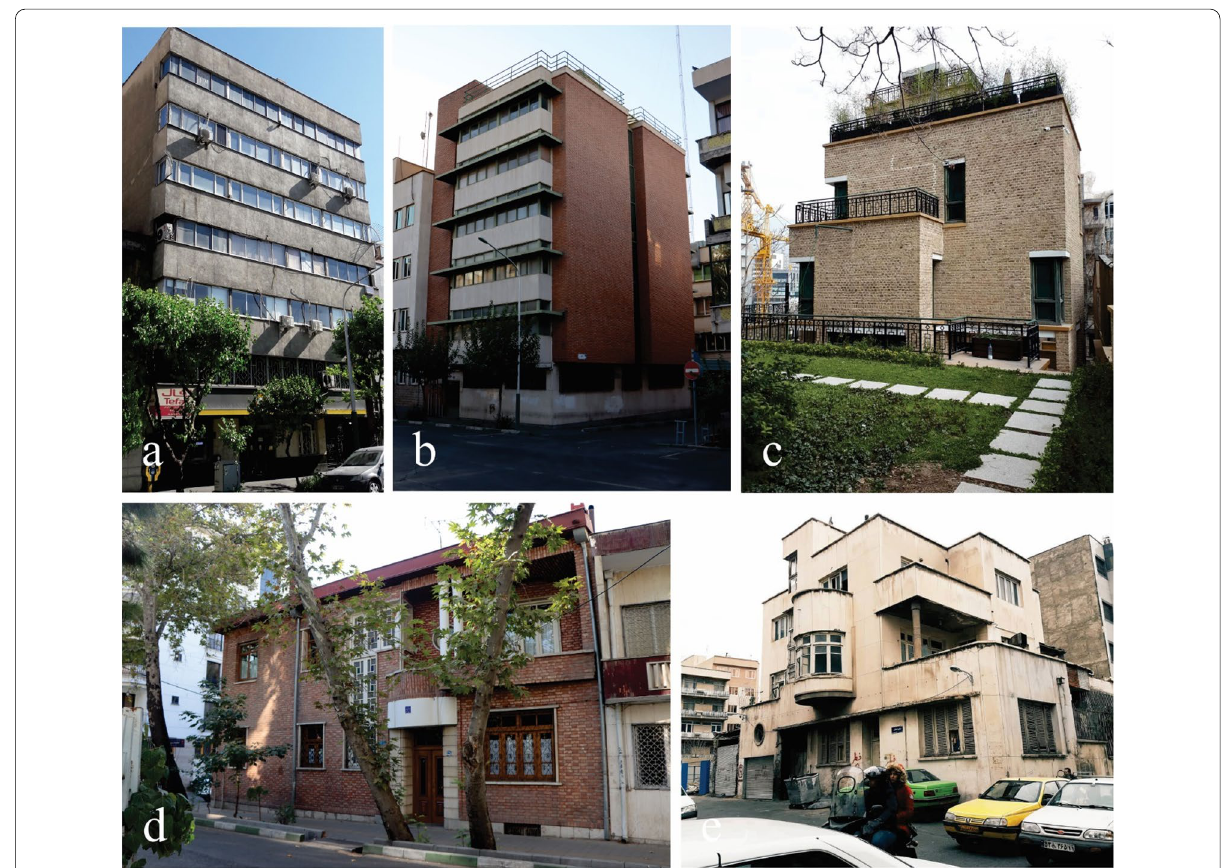
Fig. 8 Urban facades of Pahlavi period in Tehran; a Felestin S St; b Bozorgmehr St; c Golnar St; d Mousivand St, Shariati St; e Simi